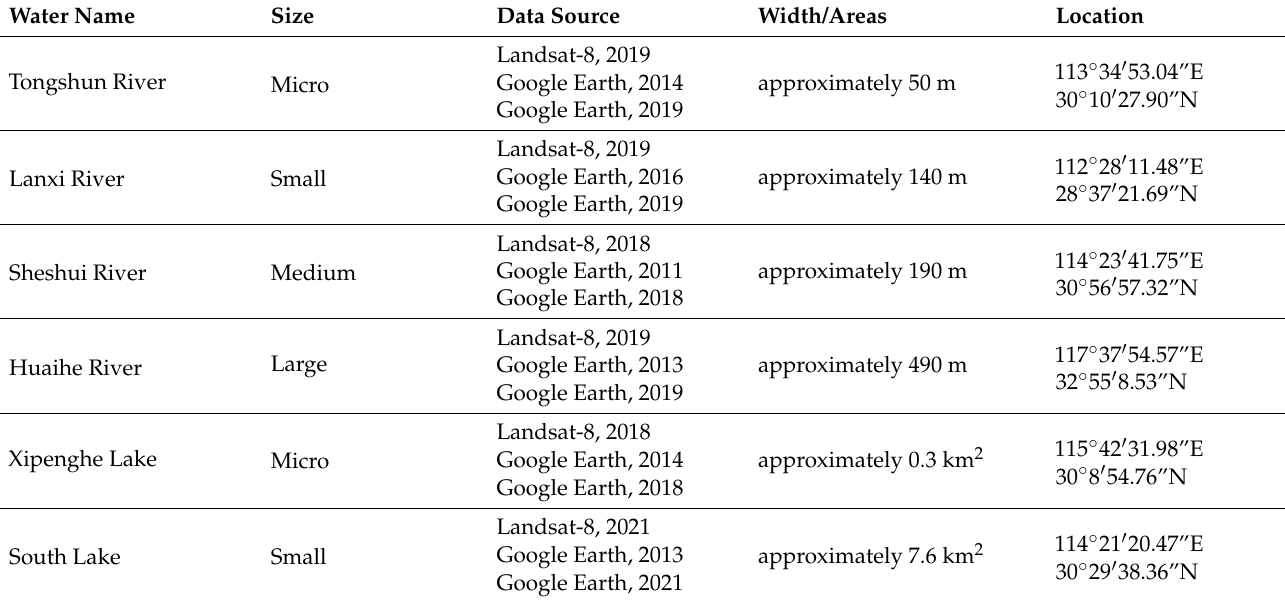
Table 1. Information about the Experimental